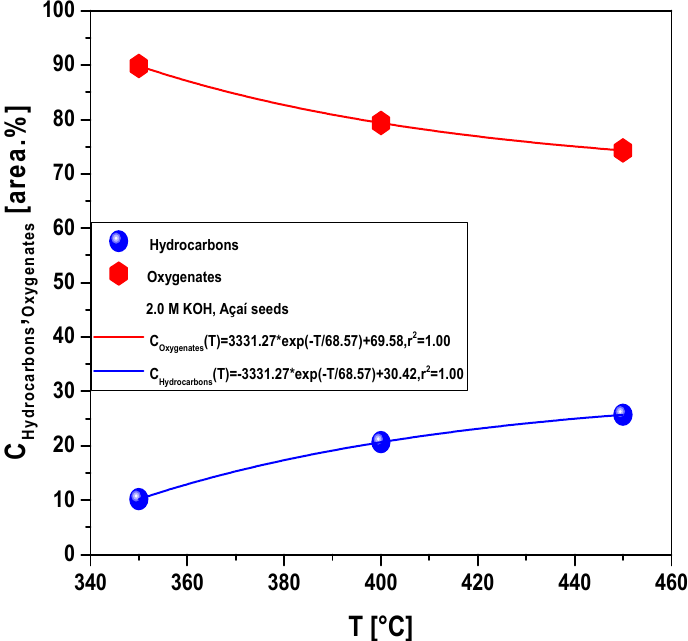
Figure 5. Concentration of hydrocarbons and oxygenates in bio-oil by pyrolysis of Aça í seeds, activated with 2.0 M KOH solution, at 350, 400, and 450 ◦ C, 1.0 atmosphere, in laboratory scale. The acid value (acidity) of bio-oils obtained by pyrolysis of Açaí seeds, activated with 2.0 M KOH solution, at 350, 400, and 450 °C, 1.0 atmosphere, in laboratory scale, is shown